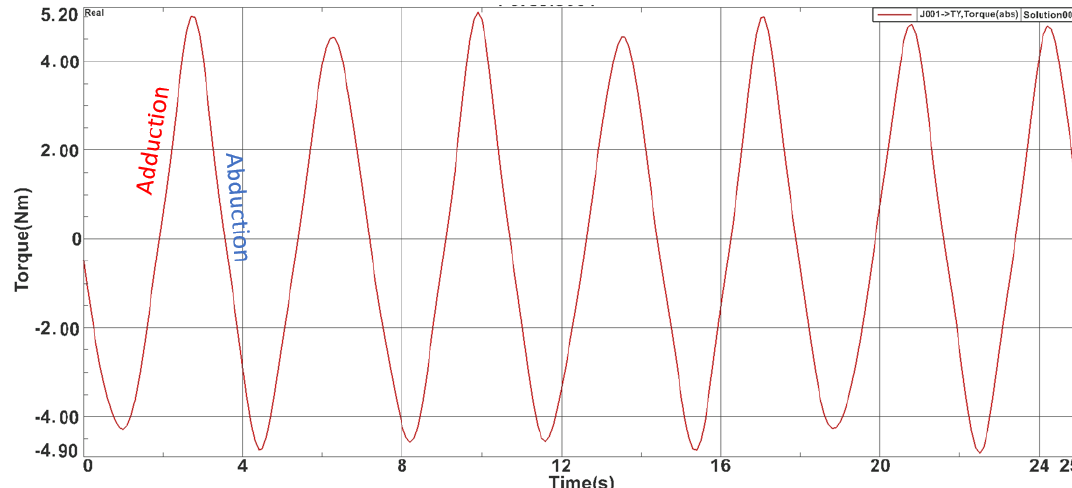
Figure 6. Torques recorded during the adduction-abduction module simulation.